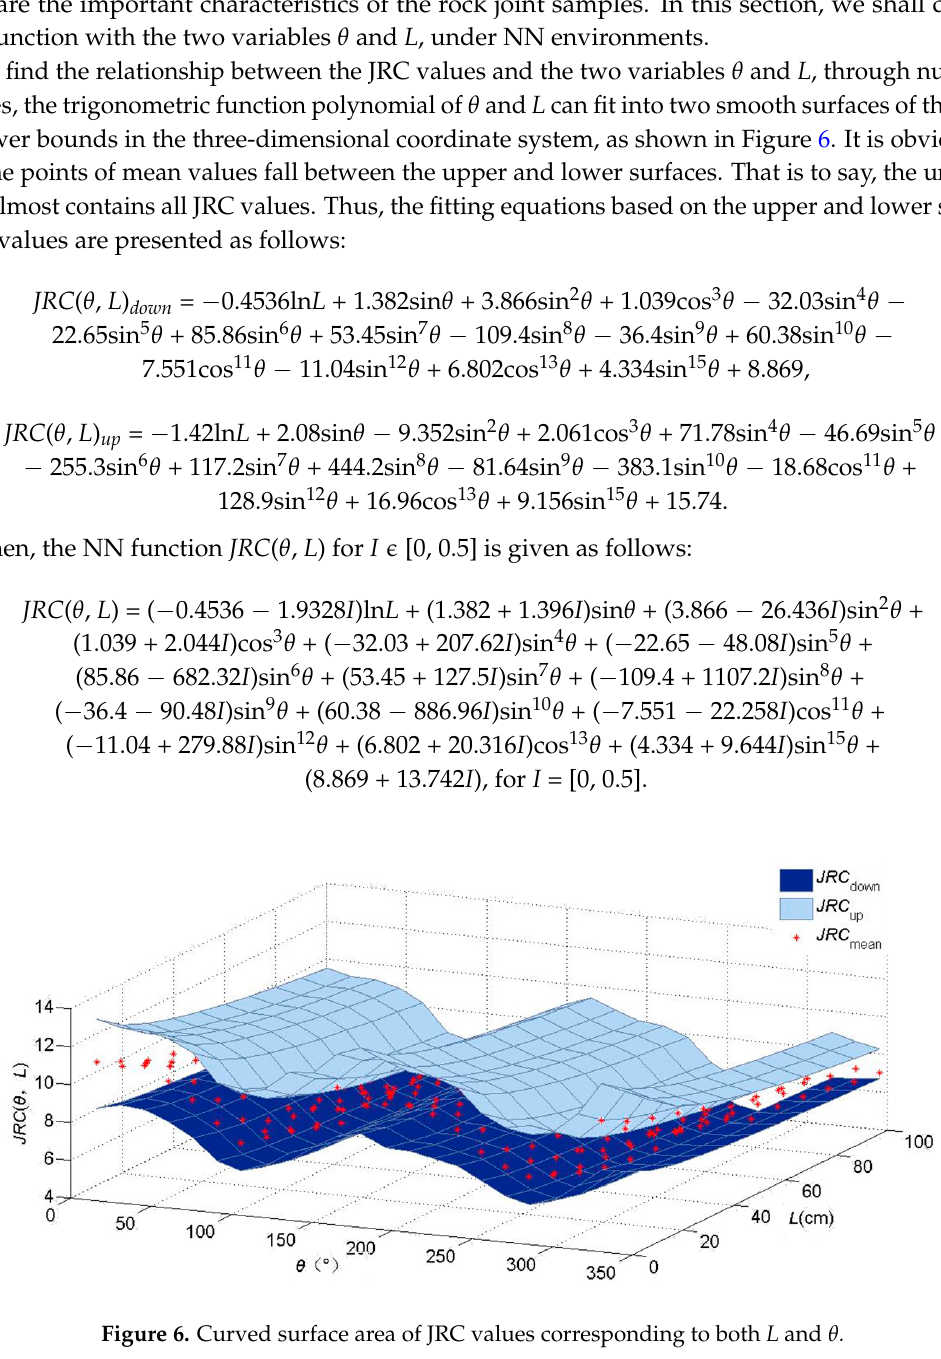
Figure 6. Curved surface area of JRC values corresponding to both L and θ .